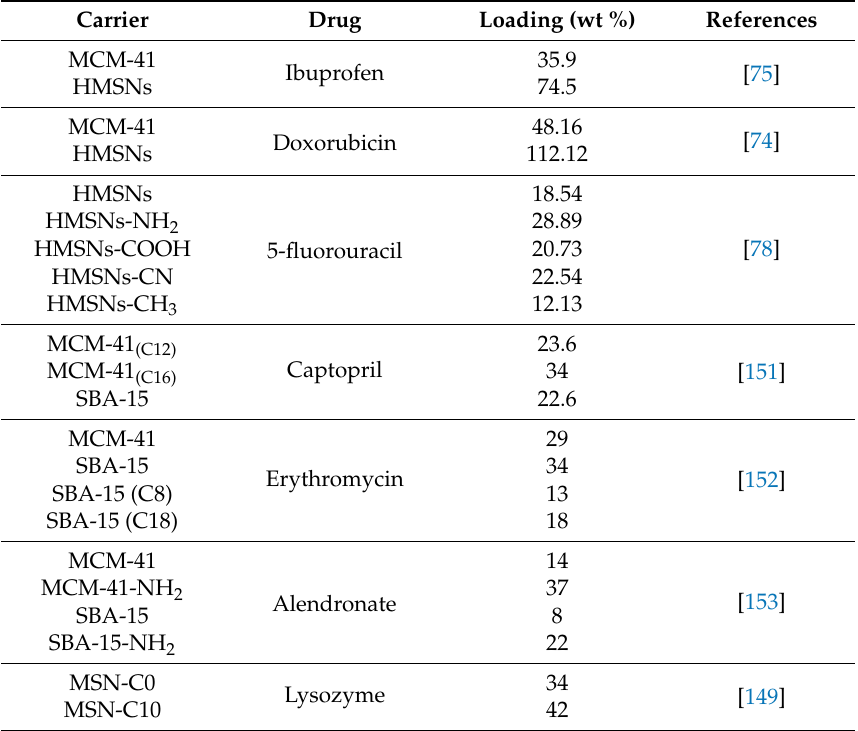
Table 4. Comparison of loading in